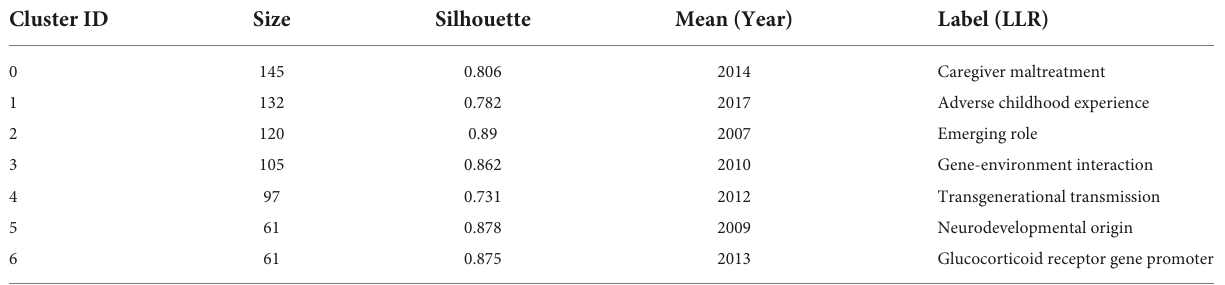
TABLE 4 The largest 7 clusters of references in the co-citation